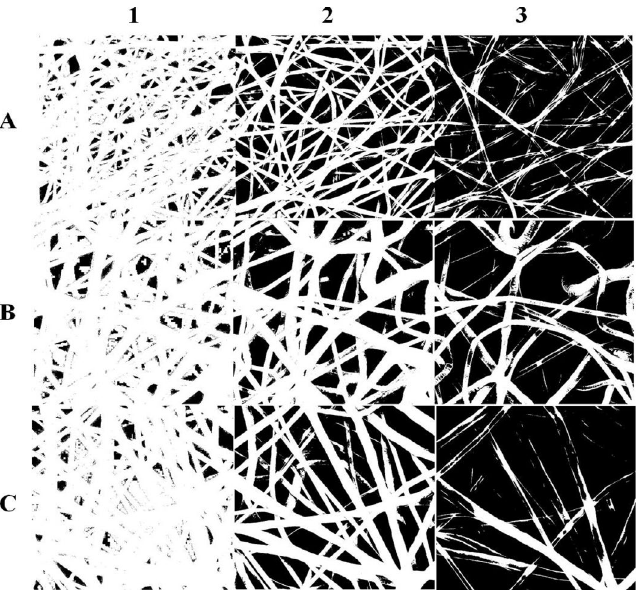
Figure 4. Nanofibrous mats different layers provided by the different thresholds of grayscale in Image J software. Rows ( A ), ( B ), and ( C ) are related to PCL 5%, 7.5%, and 10%, respectively. Columns 1, 2, and 3 are represented L1, L2, and L3 of nanofibrous mats, respectively.